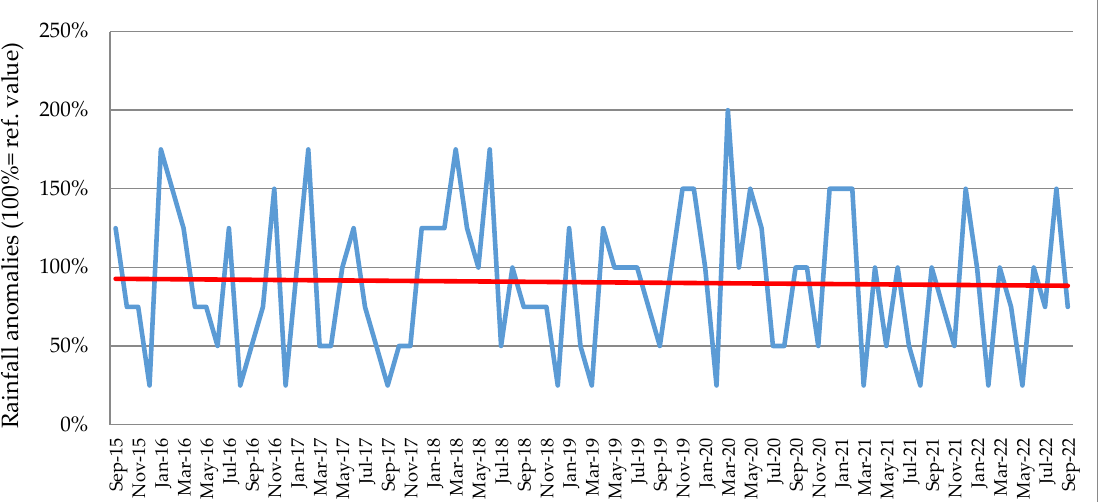
Figure 7. Infierno Glacier and surroundings. 8 September 2017. Glacier monitoring stations. 1: Glac- ier front monitoring station; 2: Glacier lateral monitoring station. Source: Google Earth [54].